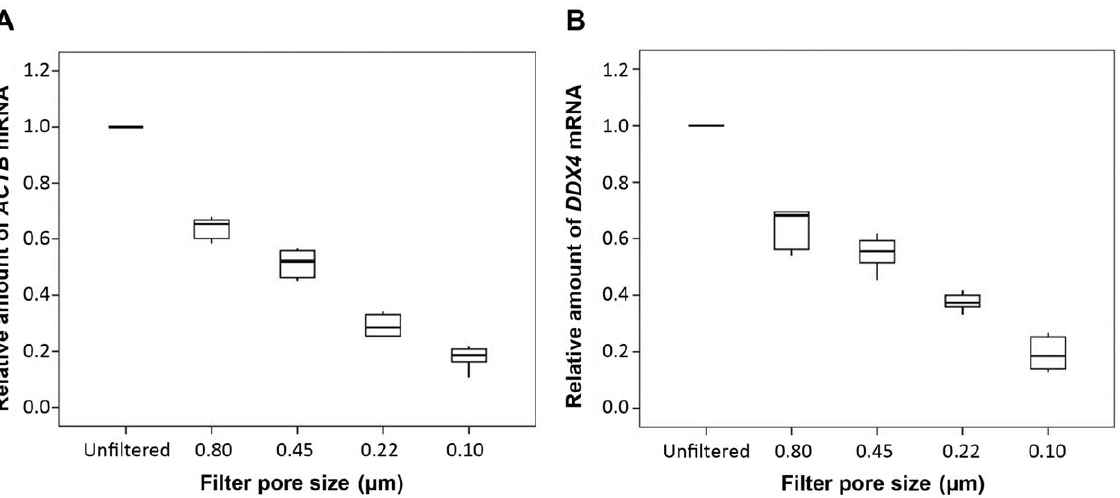
Figure 3. The representative result of heterogeneous in quantity of cfsRNA according to size of SMVs. SMVs suspensions from 6 healthy participants were filtered through 0.80, 0.45, 0.22 and 0.10 m m pores. The amount of mRNAs at each pore size was normalized to the unfiltered aliquot, respectively. Horizontal lines within the boxes denote the median. The boxes represent the interval between the 25th and 75th percentiles, and the whiskers represent the interval between the 2.5th and 97.5th percentiles.